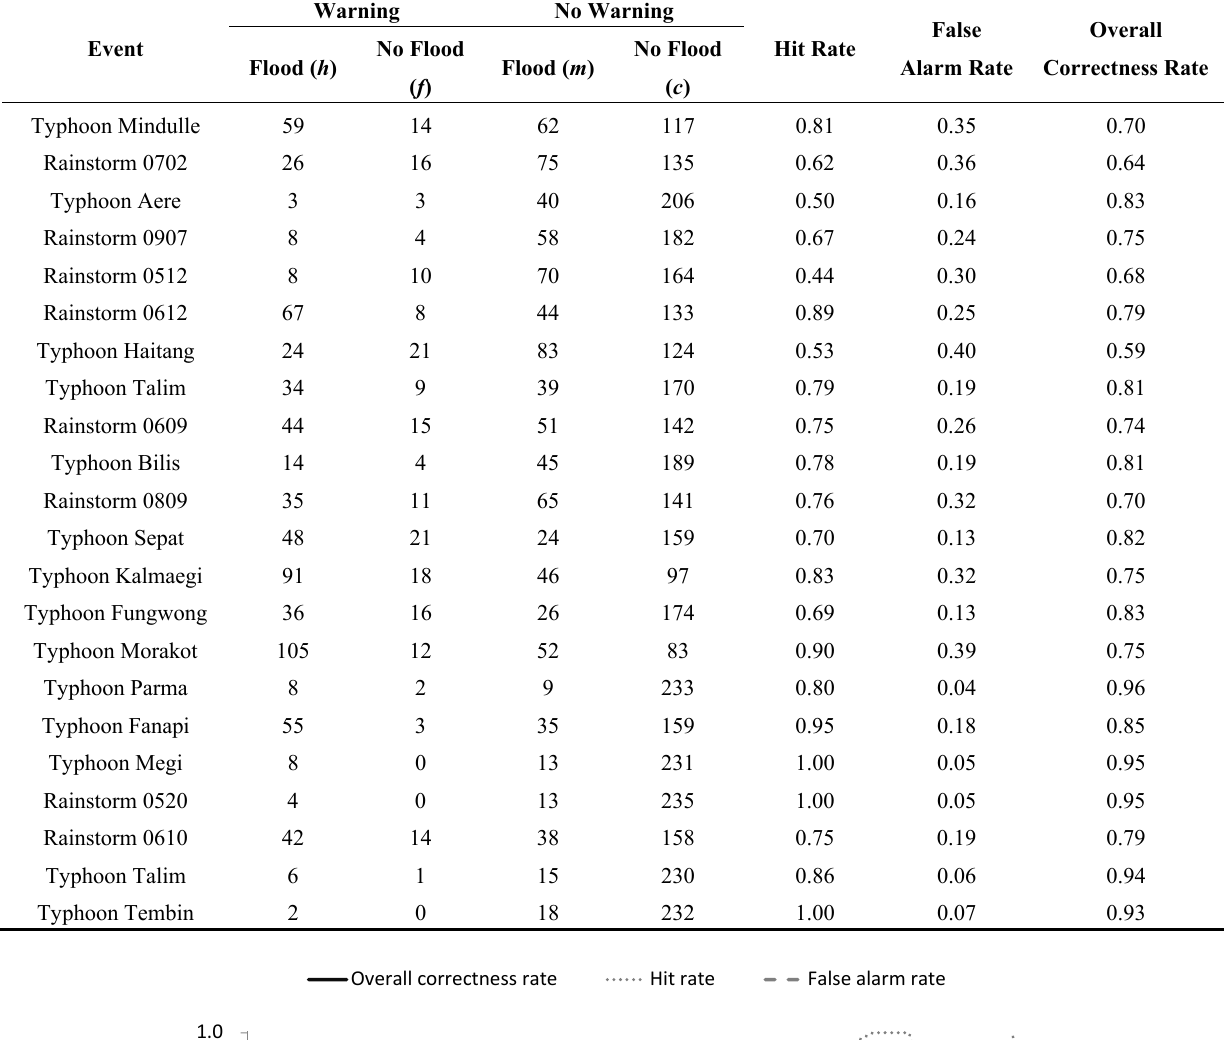
Table 3. Contingency table for warning performance assessment.